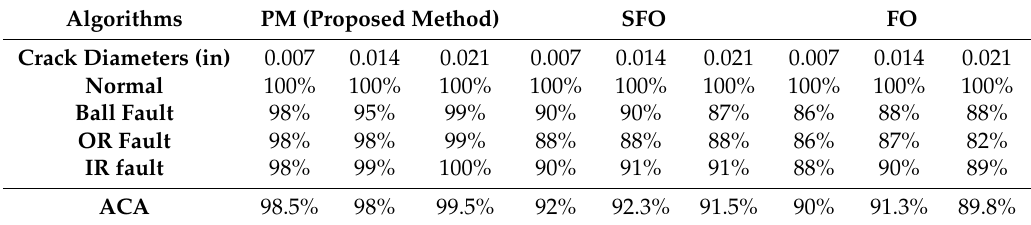
Table 5. The single fault diagnosis accuracy for 2 hp torque